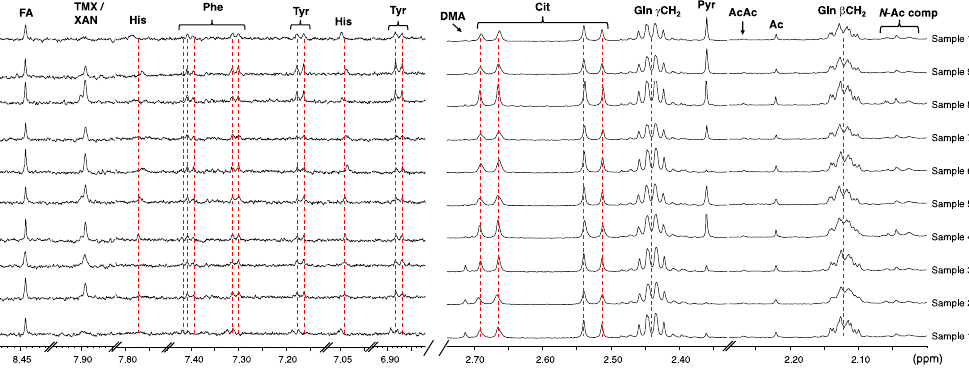
Figure 3. Stack plot of two spectral regions of the proton spectra of 10 CSF samples prepared as described in text showing consistency of metabolite resonances typically affected by differences in ionic strength and pH (600 MHz, 298 K, phosphate buffer 50 mM, pH 7.30–7.69, 10% D 2 O, line broadening = 0.5 Hz). Note: For compound abbreviations, see Table 2.